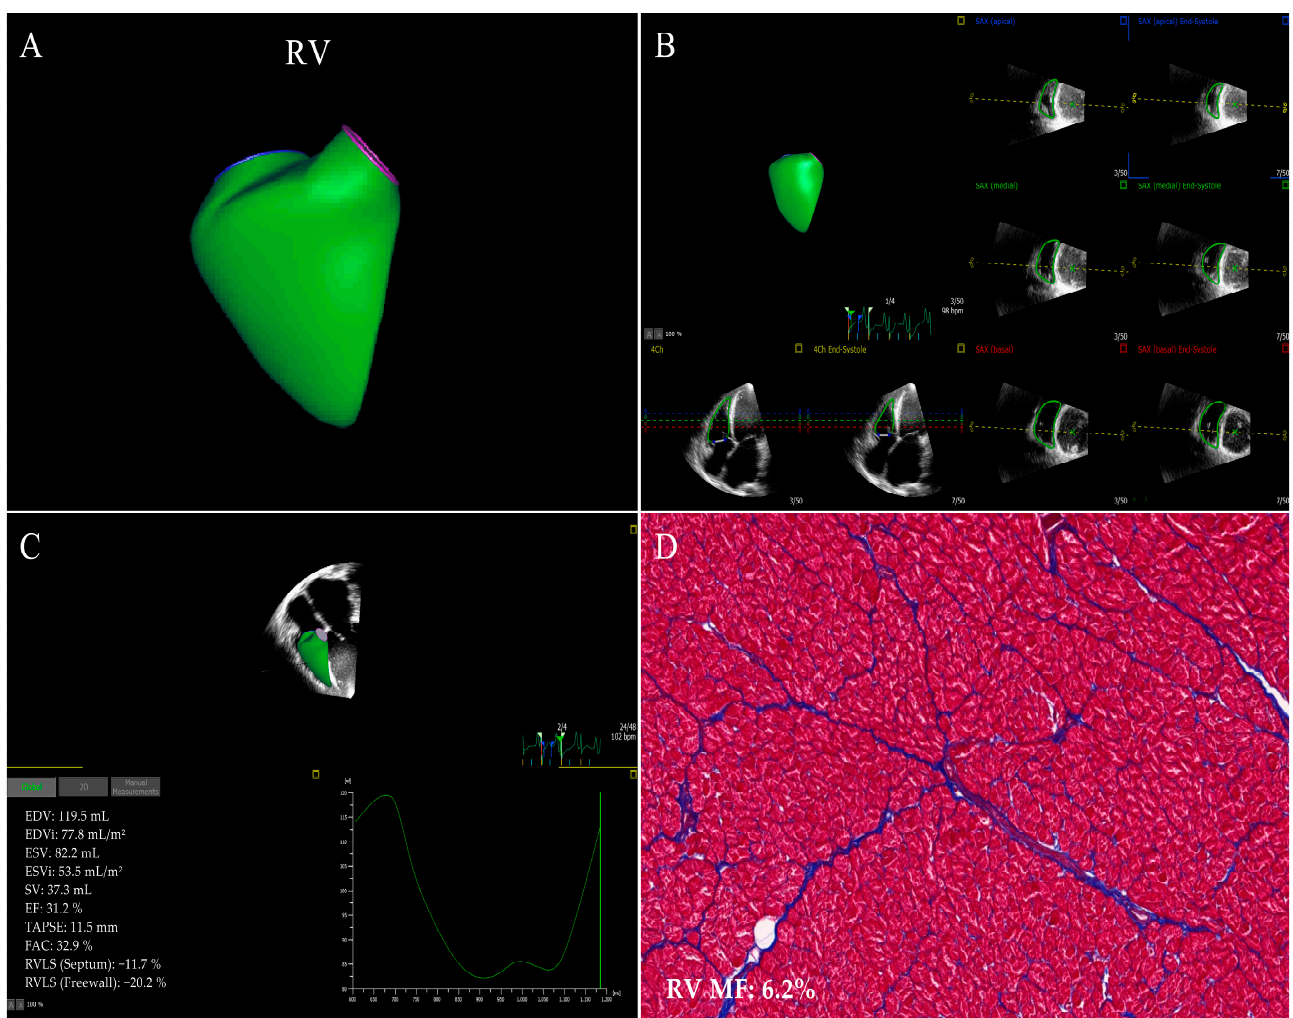
Figure 2. RV images of 3D − STE strain in a HF patient who underwent the heart transplantation. ( A ) Three − dimensional RV reconstruction image. ( B ) RV endocardial border outlining and tracking. ( C ) longitudinal strain of RV septum and free wall. ( D ) Example of RV myocardial samples stained with Masson’s staining acquired from the explanted heart (original magnification × 200). RV: right ventricular; other abbreviations as in Figure 1.